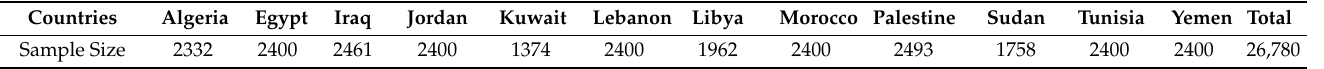
Table A1. Number of respondents to the ABS by